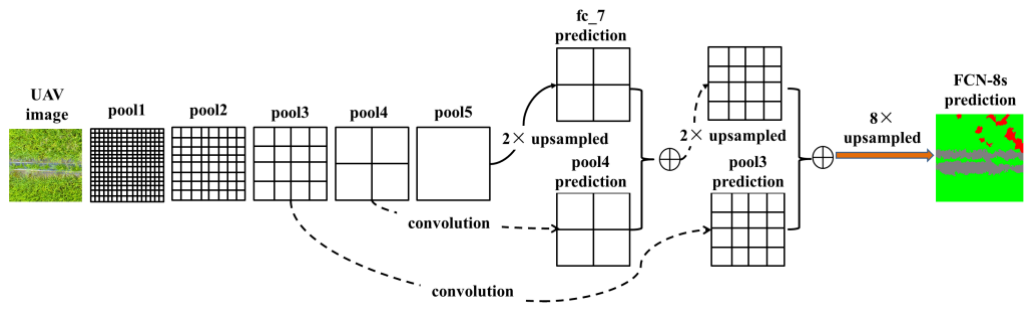
Figure 9. Illustration of skip architecture for FCN-8s. Only the pooling and prediction layers are shown, and other types of layers are ignored in this figure.